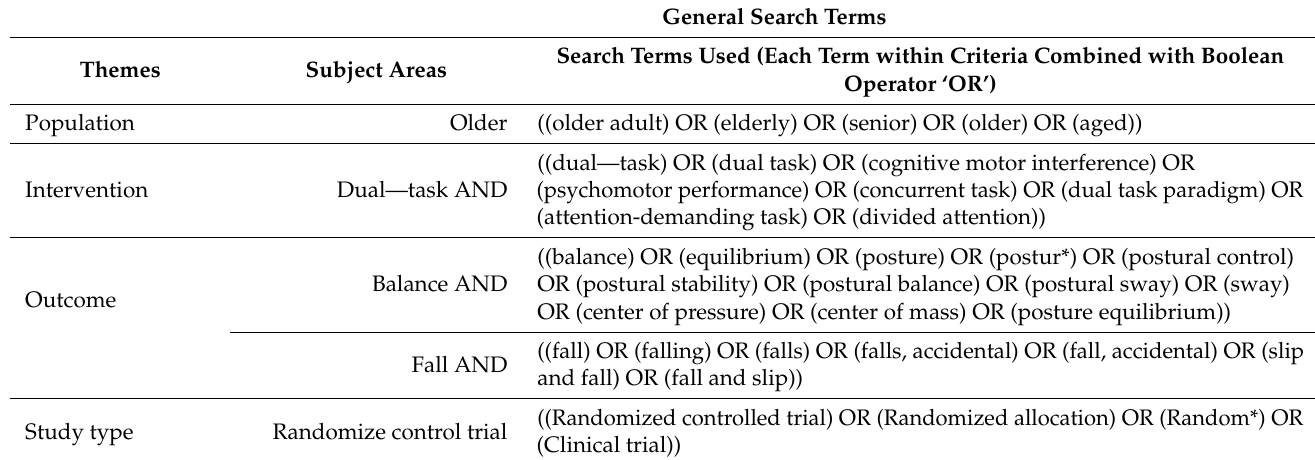
Table A1. Search terms and search strategy for PubMed.